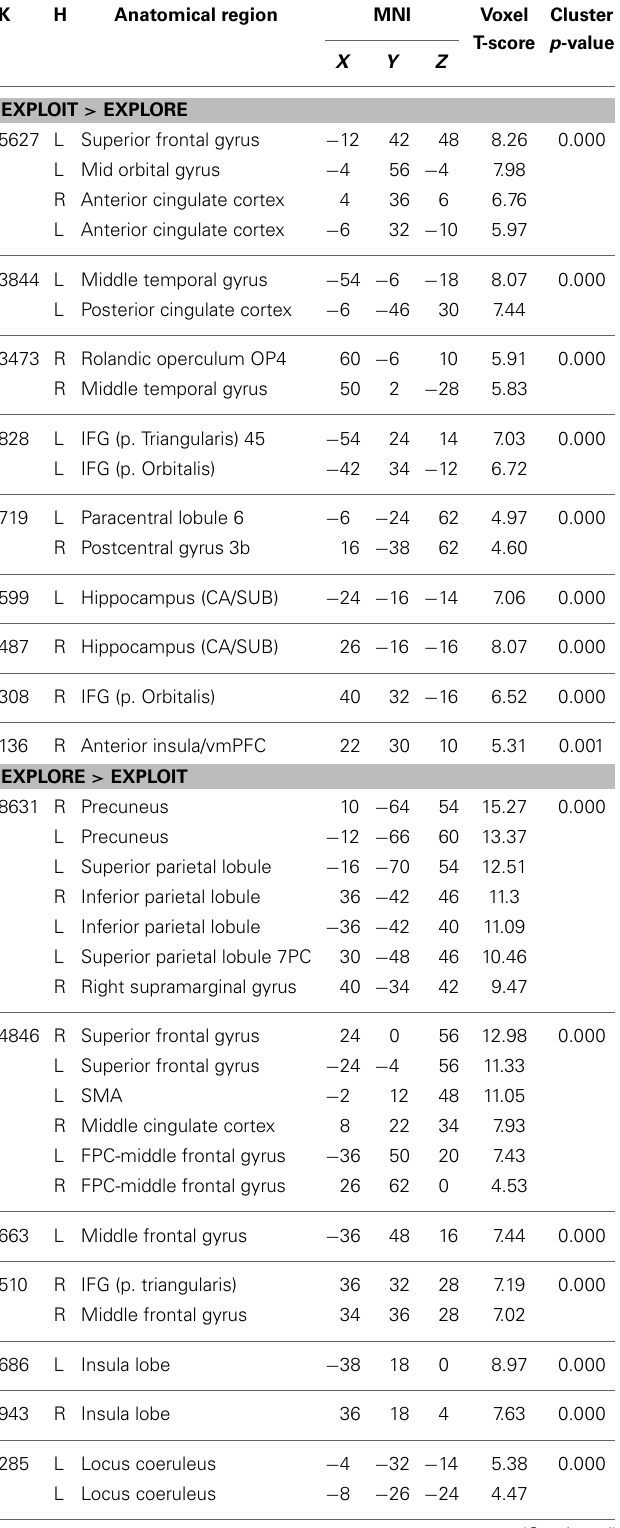
Table 3 | Neural correlates of exploitative vs. explorative choice.